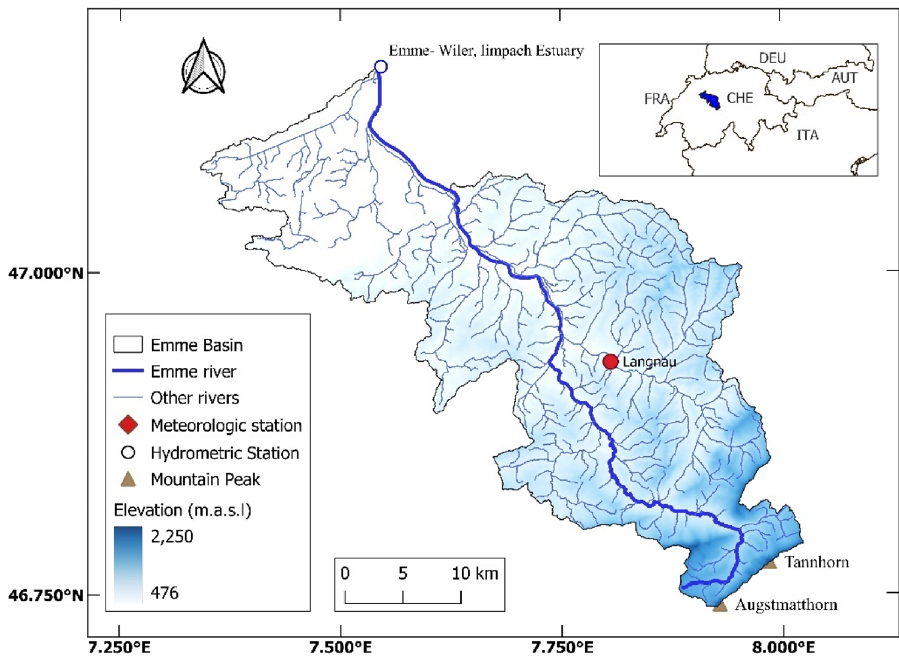
Figure 2. The geographical map of the Emme watershed in central Switzerland. Figure was created using the open-source and free QGIS V3.18. The open-access European Digital Elevation Model (EU-DEM), version 1.1 file was retrieved from Copernicus Land Monitoring Service (https:// land. coper nicus. eu/ image ry- in- situ/ eu- dem/ eu- dem- v1.1? tab= metad ata). The catchment shape file and the river network geospatial data were retrieved from the open-access Hydrological Atlas of Switzerland (https:// hydro maps. ch/) 49 .